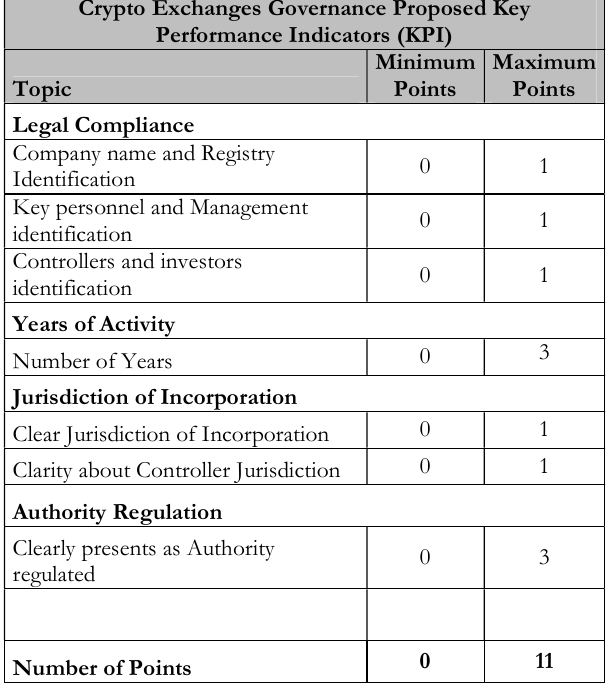
Table 2. KPI Score Summary